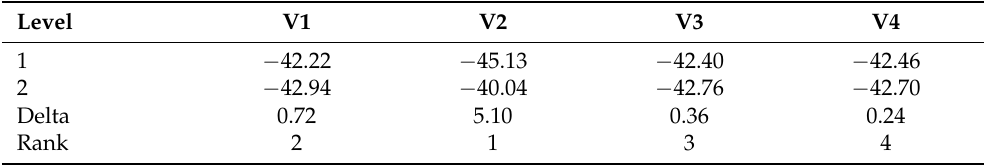
Table 7. Response for signal to noise ratios (smaller is better).